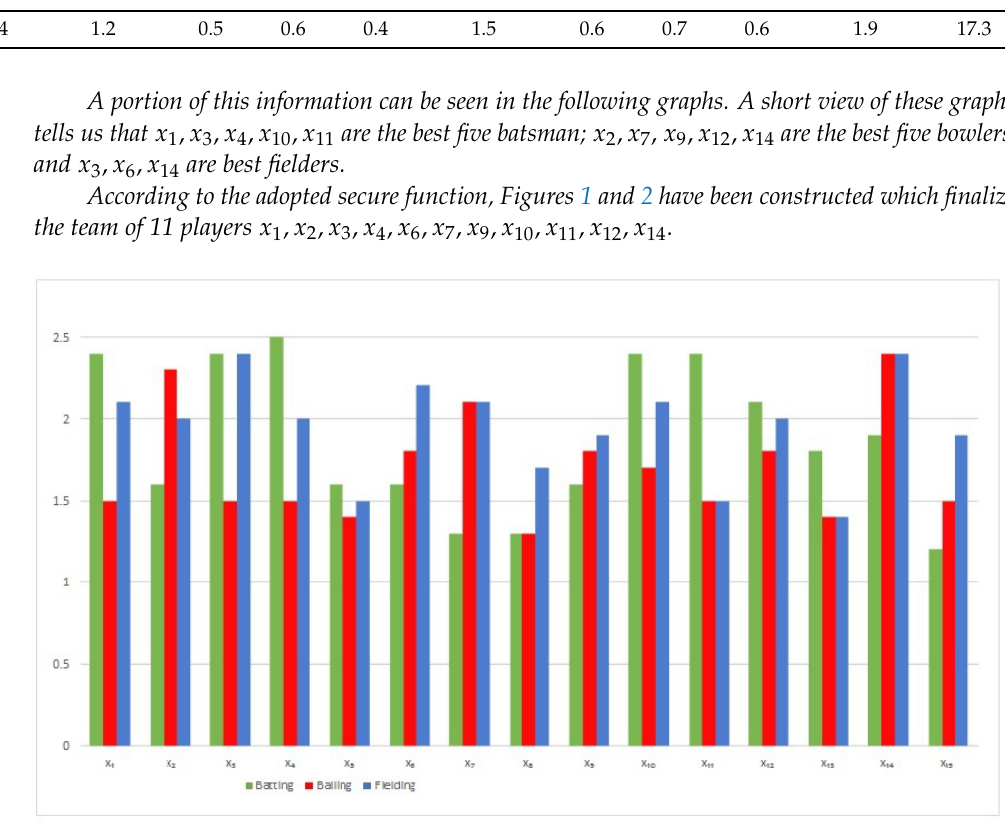
Figure 1. Individual